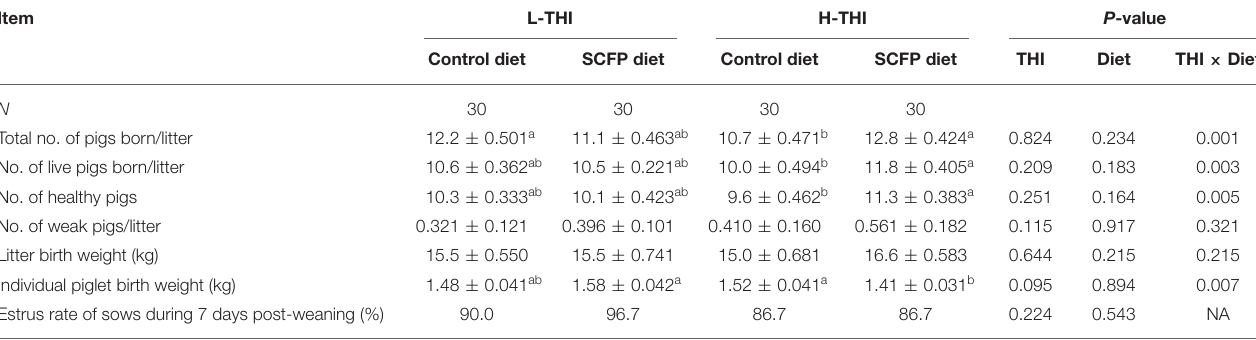
TABLE 3 | Effects of dietary supplementation of Saccharomyces cerevisiae fermentation product during late pregnancy and lactation on reproductive performance of sows in a subtropical climate (Mean ± SE) * .